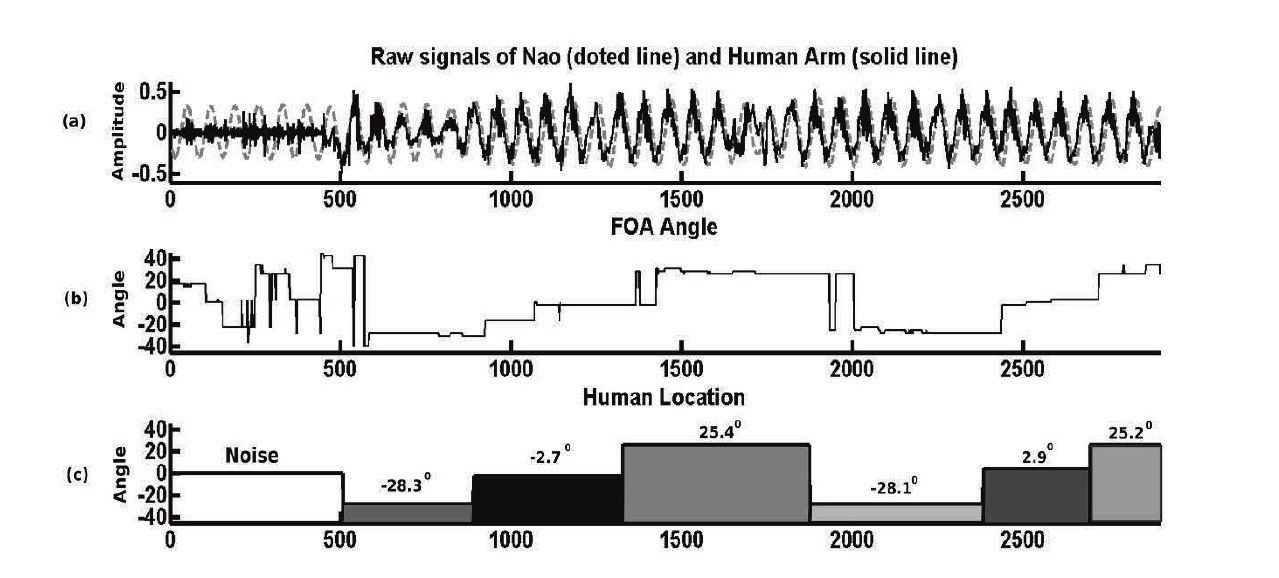
Figure 9. (a)Nao’soscillationsalongwithinteractingagentmotionsignal(b)FluctuatingangleofFOAaccordingtotherhythmicmotion(c)Itdescribestheinteractant’s location in front of Nao.